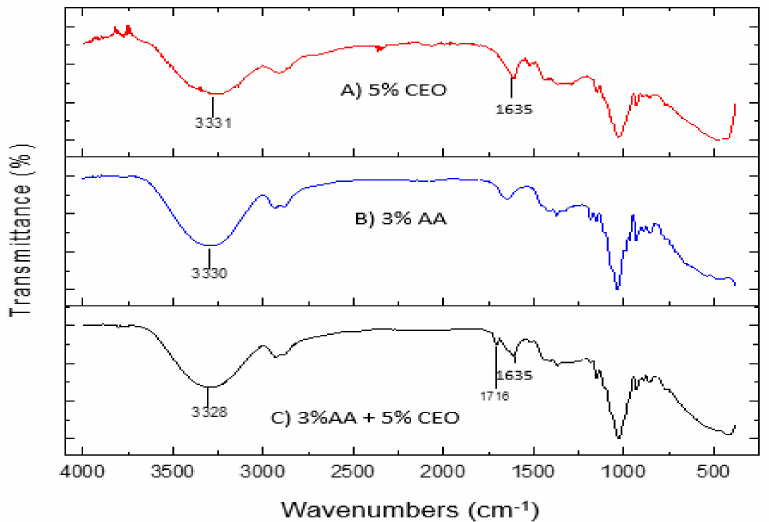
Figure 6. FTIR spectra of ( A ) Biofilm with 5% CEO; ( B ) biofilm with 3% acetic acid; and ( C ) biofilm with 5% CEO and 3% acetic